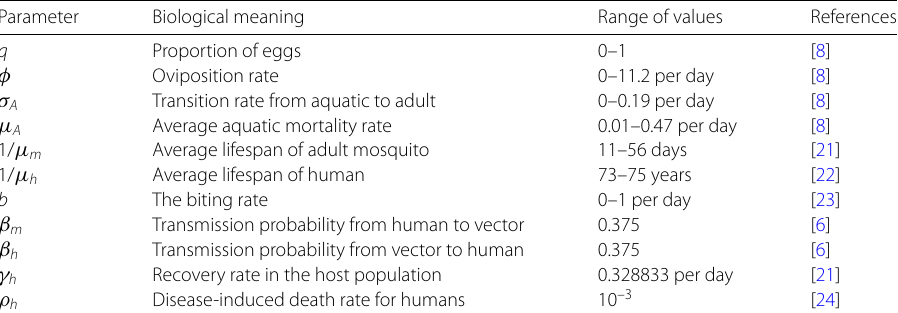
Table 1 Description of the dengue model (3) parameters and their possible feasible ranges Parameter Biological meaning Range of values q Proportion of eggs